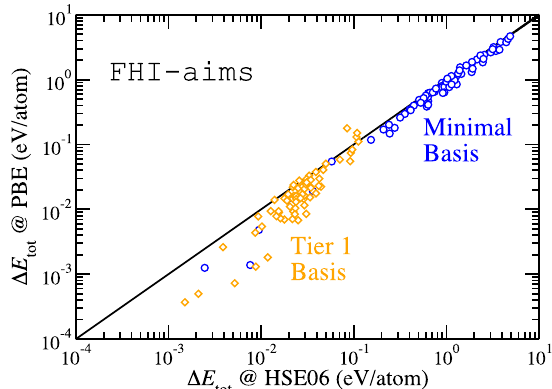
Fig. 6 Average (black circles) and maximum numerical error (red squares) for the Kohn-Sham band gap E BG as function of the number of basis functions per electron. All calculations were performed with FHI-aims for 71 elemental solids using the PBE functional and an 8 Å k-point density. Vertical black (L/T) and gray lines (T1,T2,T3) denote the average number of basis functions for different settings and tiers, as in Fig. 1. The inlet shows the relative errors in percent with respect to the fully converged band gap. The dashed green line highlights the typical error acceptable for obtaining reliable electronic properties, e.g., Fermi-energies and effective masses.